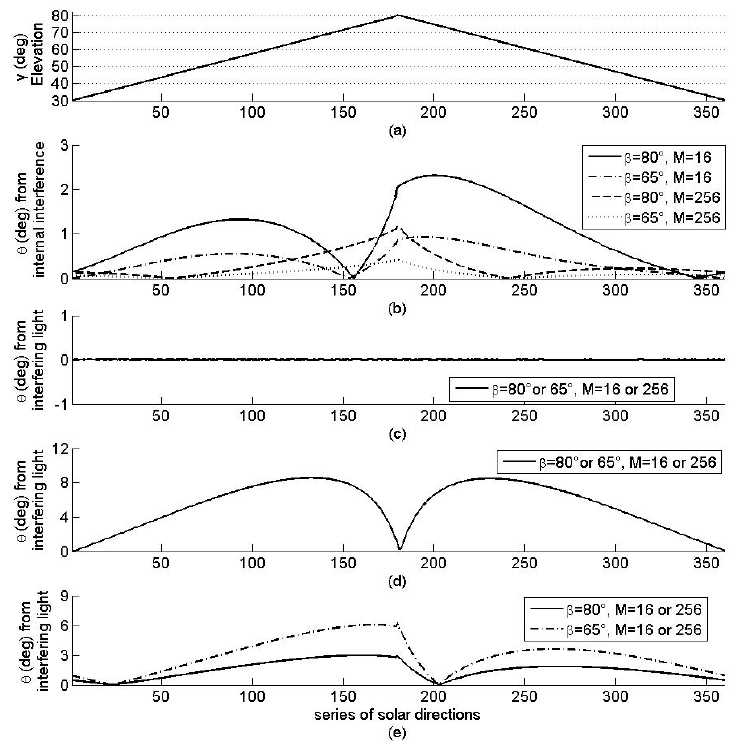
Figure 4. Solar azimuth angle ( a ) and the error θ in the azimuth angle for four arrays with different interference: ( b ) internal interference; ( c – e ) external interference caused by interfering light sources at positions 1, 2, and 3